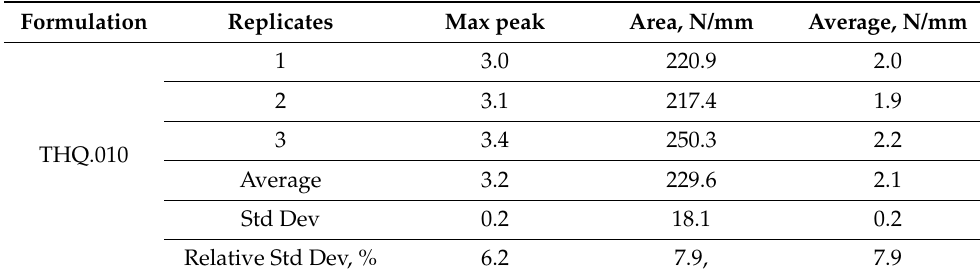
Table 5. Peel adhesion test (90 ◦ ) on thymoquinone loaded BC dressings THQ.010.